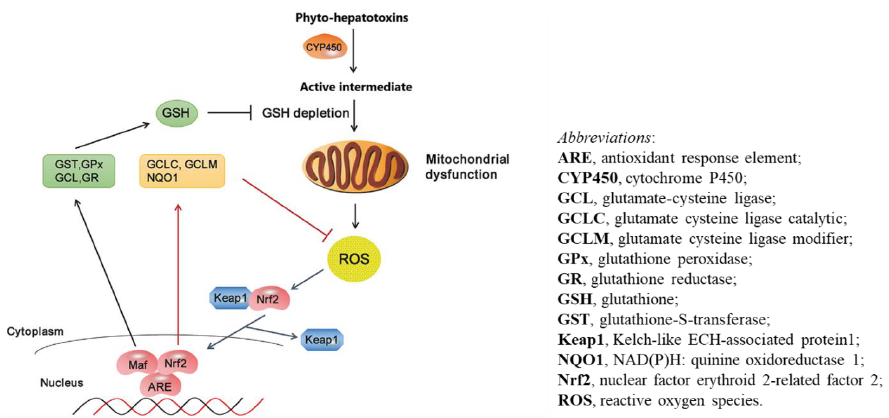
Figure 2. General structure of pyrrolizidine alkaloids.